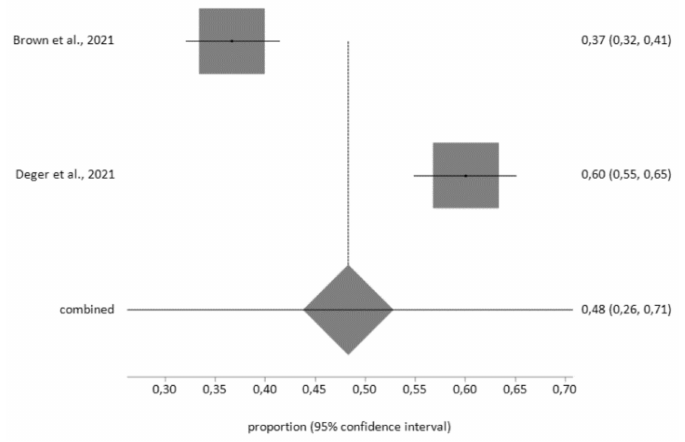
Figure 4. Prevalence of depression in obesity patients determined using the Patient Health Questionnaire—9 items (PHQ-9).